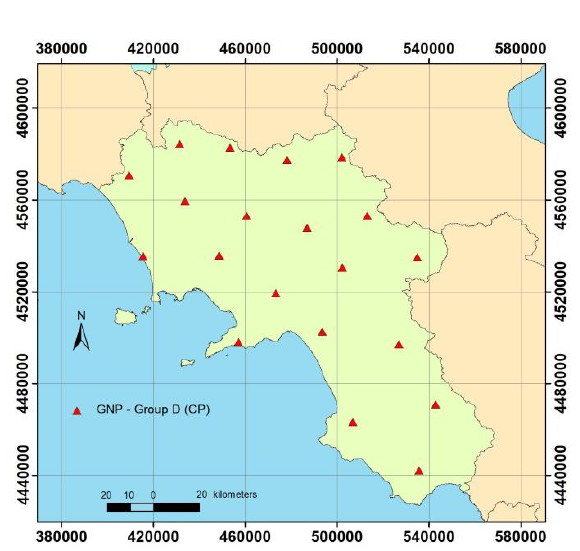
Figure 2. The localisation of the 20 GNPs used as CPs for testing the adaptations of EGM2008 on the Campania Region